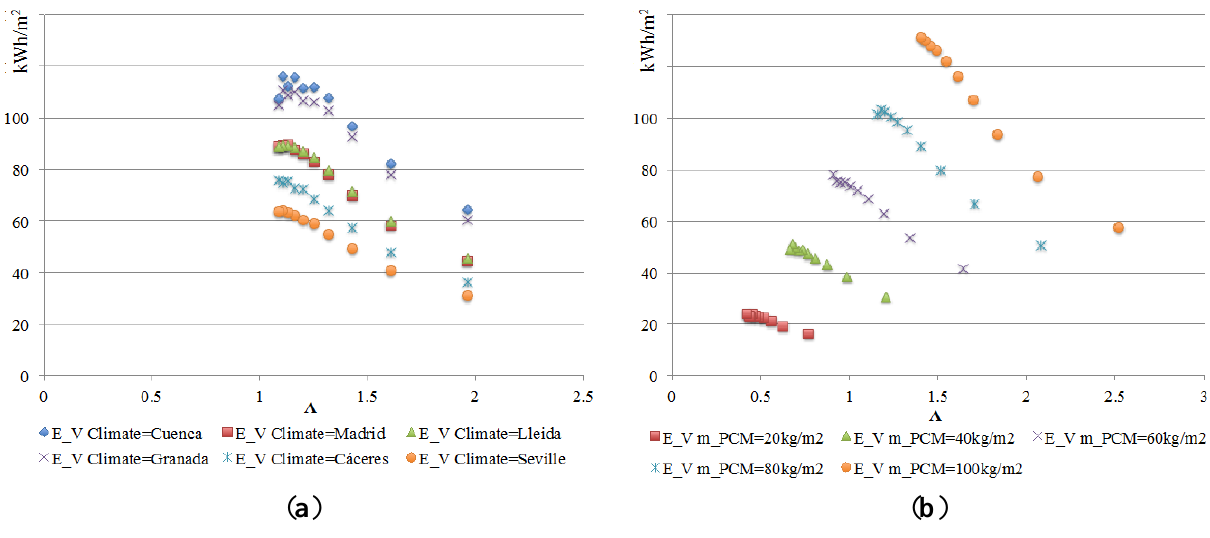
Figure 10. Ventilation energy delivered in July and August: ( a ) different climates; ( b ) different amounts of